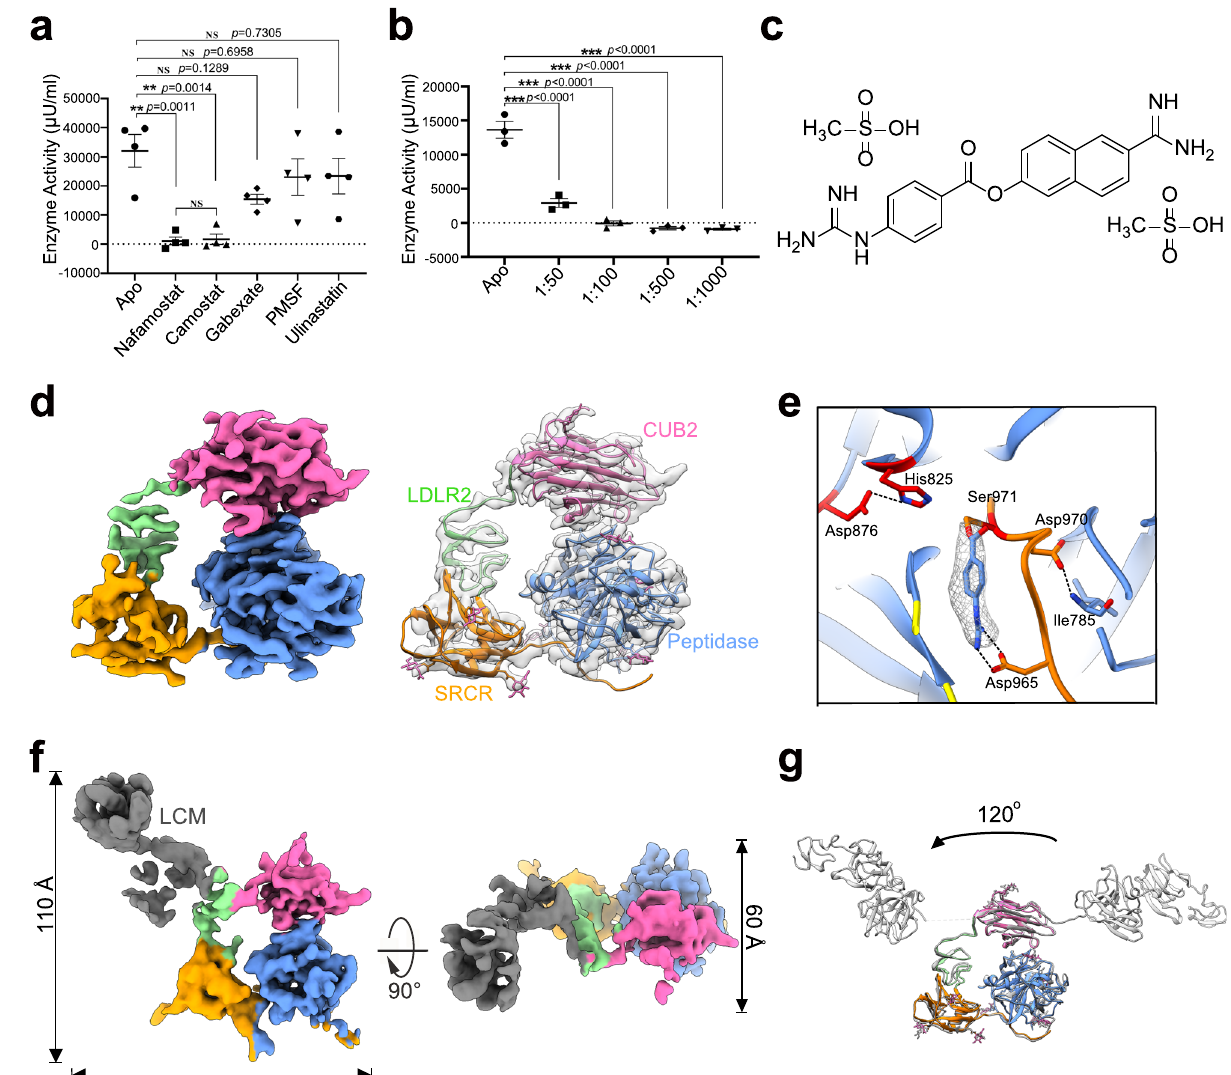
Fig. 3 | Structuralfeaturesofinhibited h EP.a Invitro activity experimentsunder different inhibitor conditions for commercial h EP. Various compounds, including nafamostat,camostat,gabexate,PMSF,andulinastatin,weretestedto fi ndthebest inhibitor of h EP. h EP only (Apo) was also tested as a positive control. Data are presented as mean values± SDs (standard deviations) from four biologically independent replicates. b In vitro h EP activity experiments. Commercial h EP